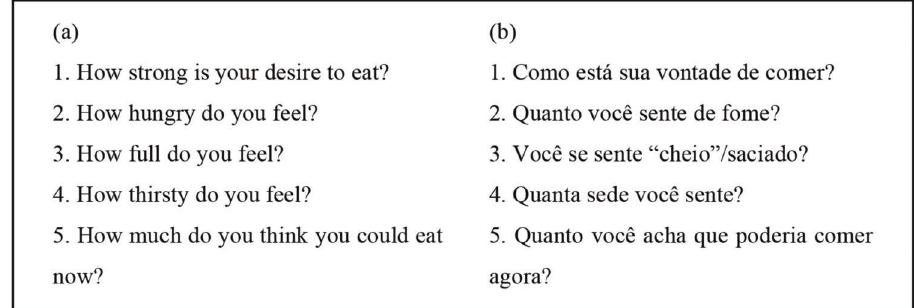
Figure 1 - (a) Original visual analog scale; (b) Appetite Assessment Scale of Brazilian Oncology Patients ‘‘ EAA-BR ’’ .